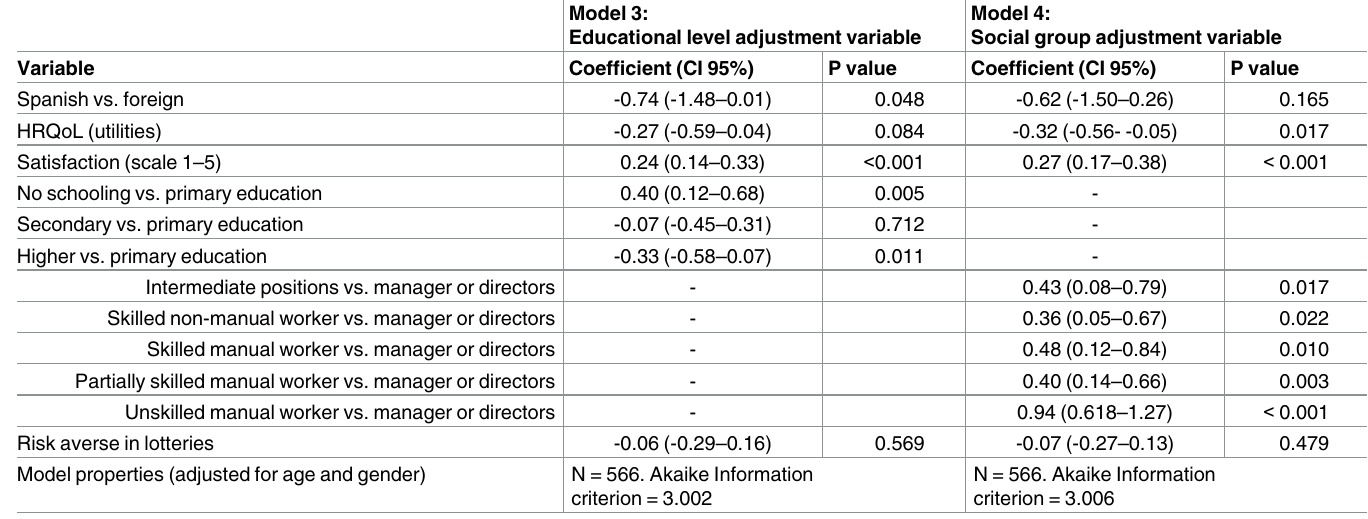
Table 3. Factors explaining the WTA/WTP ratio, measuring risk aversion by